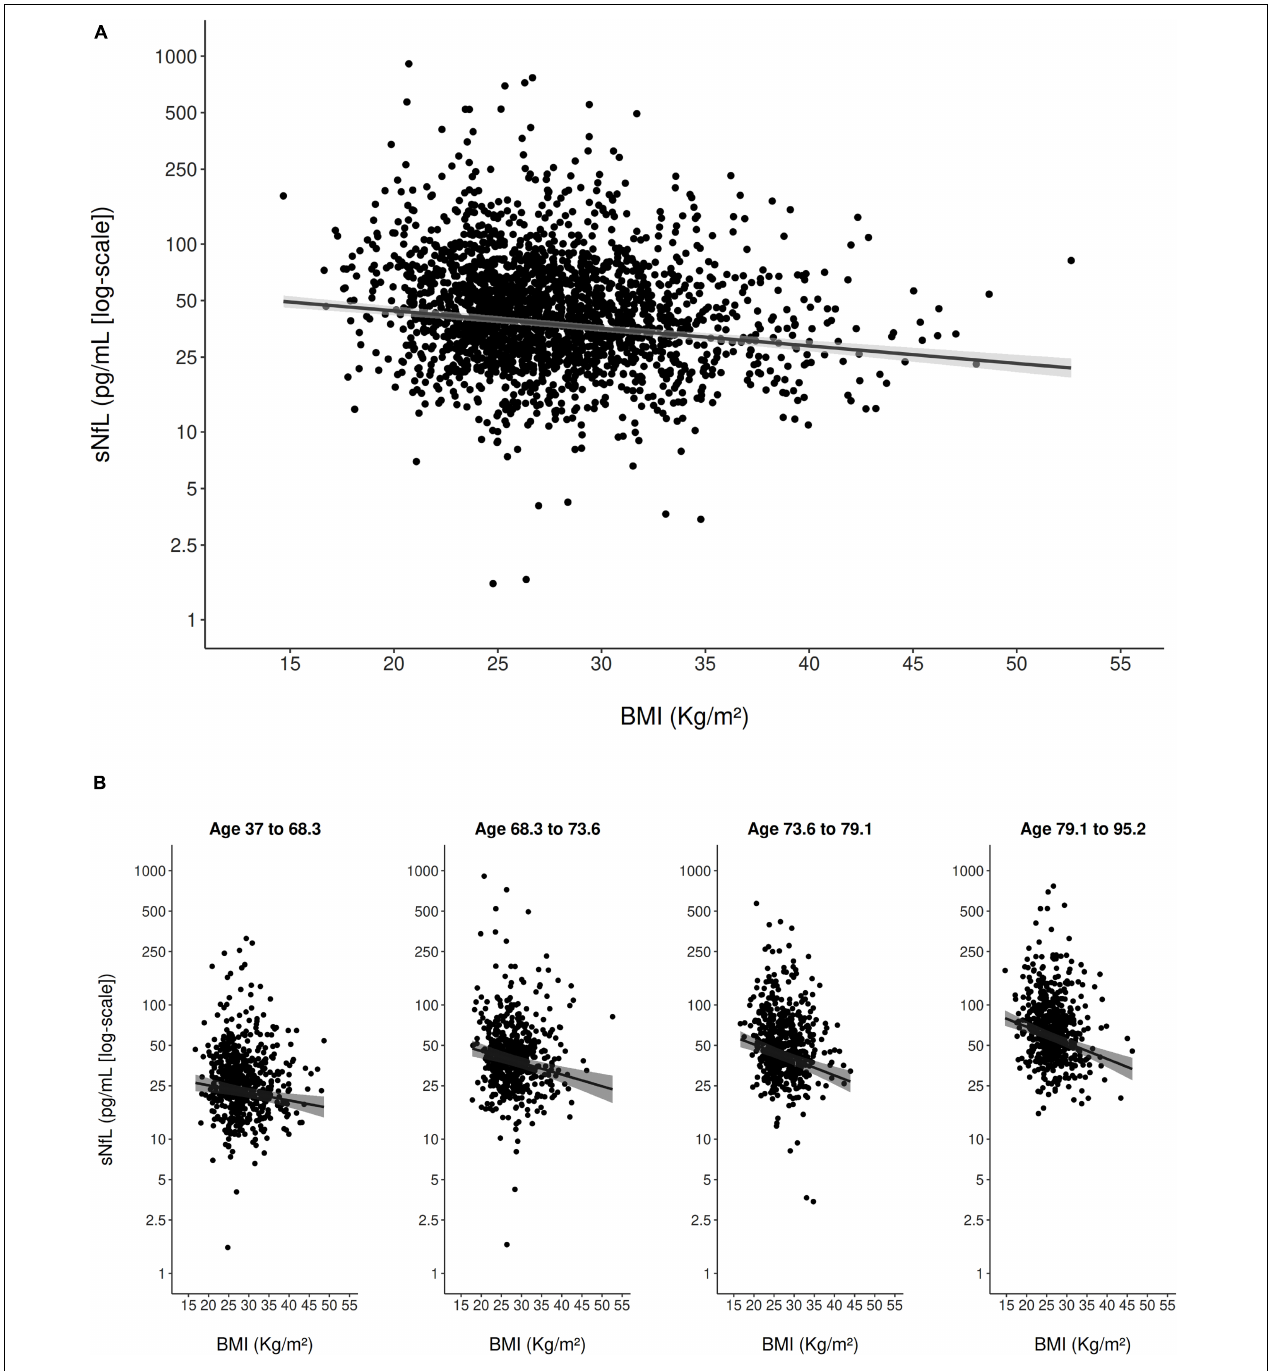
FIGURE 2 | Scatter plot of the association of BMI with sNfL (using the log scale) in the entire study population (A) and stratified to age quartiles (B) . The solid line represents the predicted values from the main multivariable model and the gray shading represents the 95% confidence